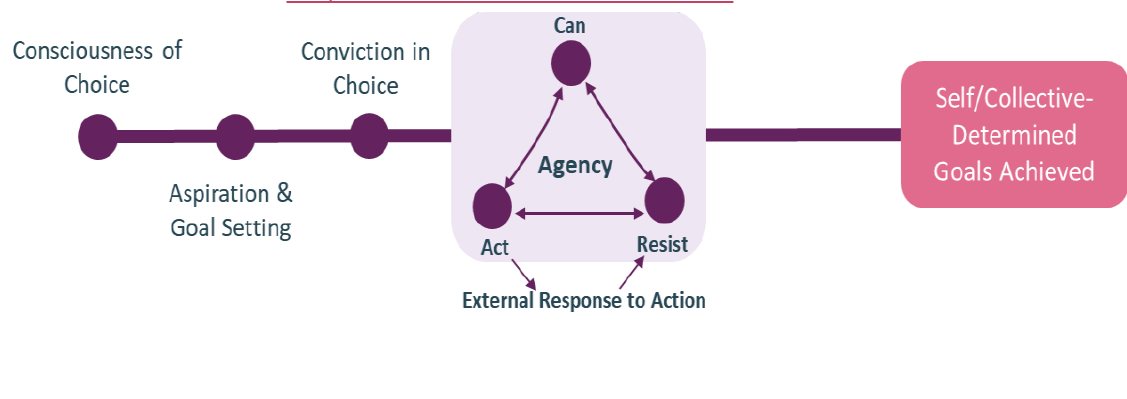
Figure 2b: Description of the Can-Act-Resist Agency Conceptualization